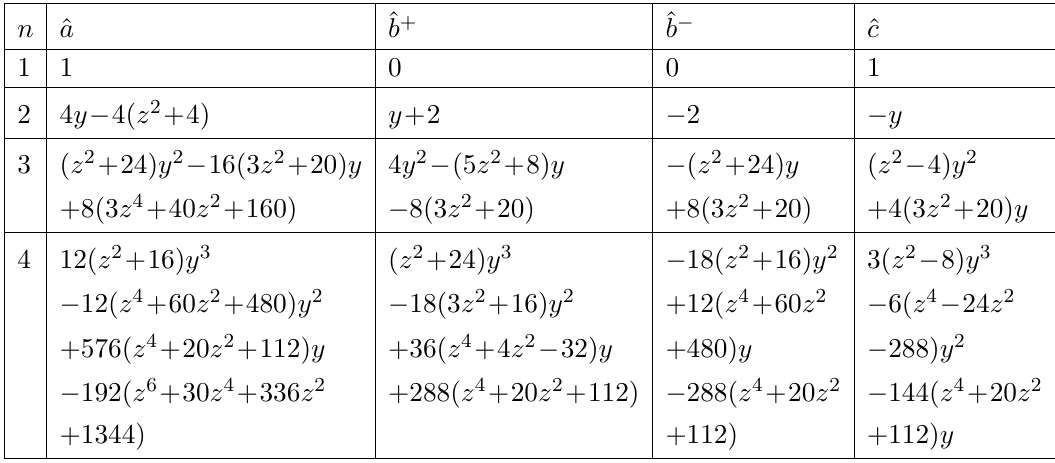
and ˆ c n . The displayed expressions must be multiplied by n (cid:0) 3 (cid:1) 2 n